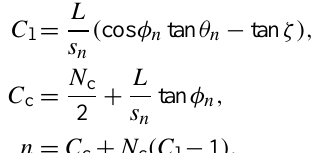
FIGURE 6. Measurement geometry for a thermal camera viewing a distant SO 2 plume. (After Prata and Bernardo (2009)).